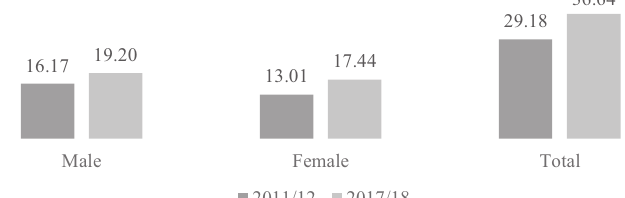
Figure 2. Enrolment of youth